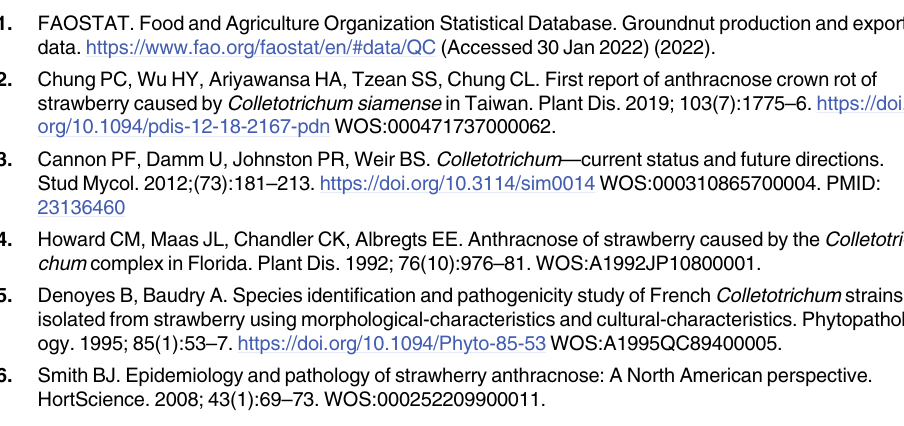
S3 Table. List of Trichoderma spp. genomes used in this study. S4 Table. List of Fusarium spp. genomes used in this